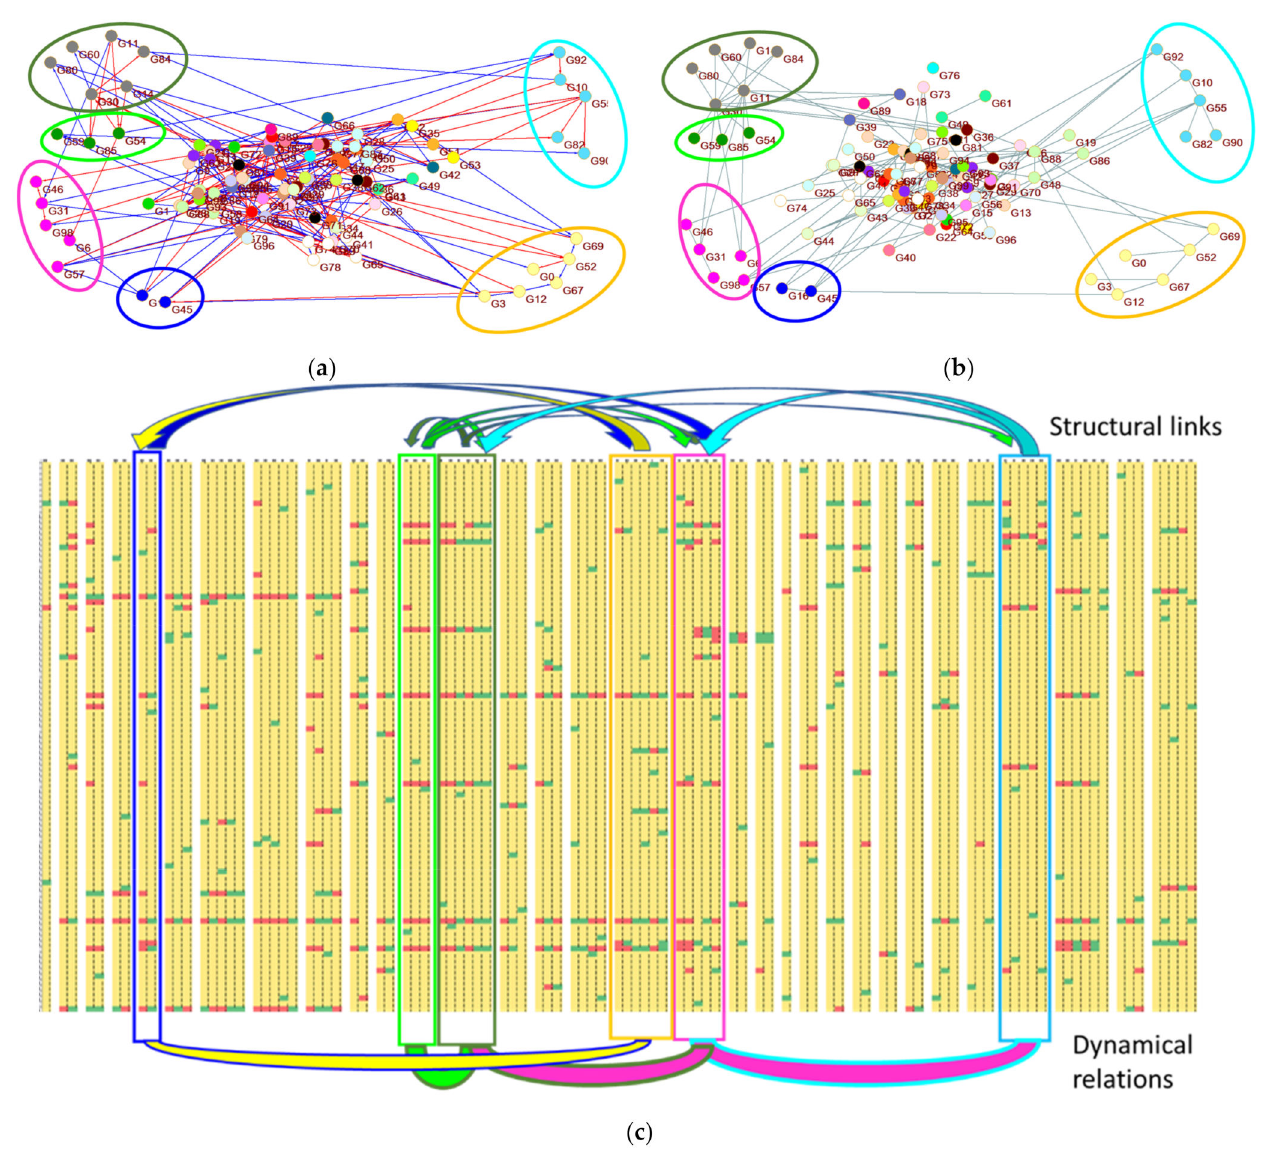
Figure 7. Characterization of RSs. ( a ) Six RSs located within the gene regulatory network of a RND system, which shows the potential links (the structural links) between the different RSs. Note that the blue RS involves two nodes that are not directly connected each other, as well as the nodes G6 and G57 are not directly connected to each other, or to other nodes of the pink RS ( b ) The same RSs located within the zI-graph_dpi , which shows the effective dynamical connections between the different RSs. ( c ) The pattern of the 32 RSs of the RND network, with in evidence the patterns of the six RSs highlighted in parts ( a ) and ( b ) of this figure—the colors of the boxes are the same colors previously used in the ellipses. The background colors of the patterns red, yellow, and green indicate levels 0, 1, and 2, respectively (“inhibition”, “indifference”, and “growth” post-KO of gene expression). In the upper part the presence of structural connections is emphasized, and in the lower part are highlighted the dynamically evident connections. Not all structural connections are dynamically